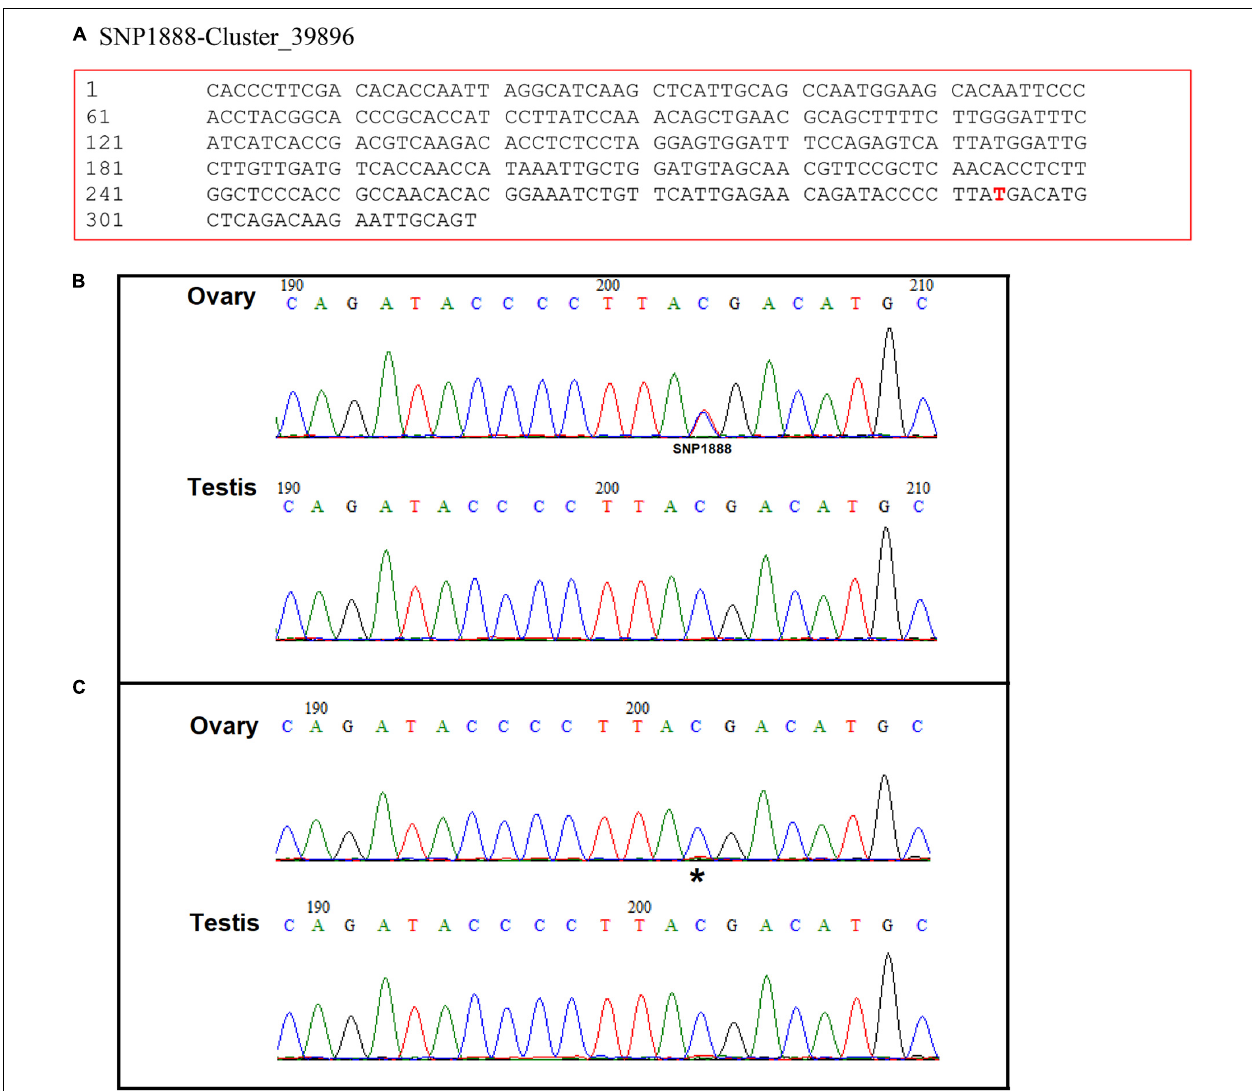
FIGURE 1 | (A) The position of Seq-1888 and its sex-specific SNP marker on the sequence (SNP 1888:T/C). Sequencing chromatograms of the ovary and testis DNA (B) and cDNA (C) in Scylla paramamosain. Double peaks indicate heterozygous and single peak indicates homozygous. Sequencing data (i.e., sequencing data for SNP discovery) are available at NCBI Sequence Read Archive (accession number SRP135178). * shows the position of SNP